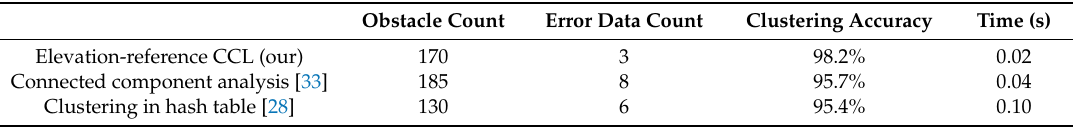
Table 2. Obstacle clustering results obtained using di ff erent